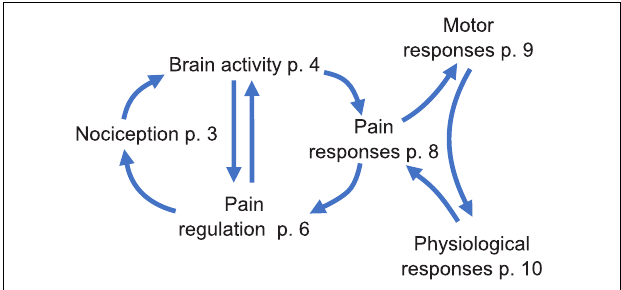
FIGURE 1 | The simplified view of the cycle of pain (for illustrative purposes) with the numbers of corresponding pages of the paper.